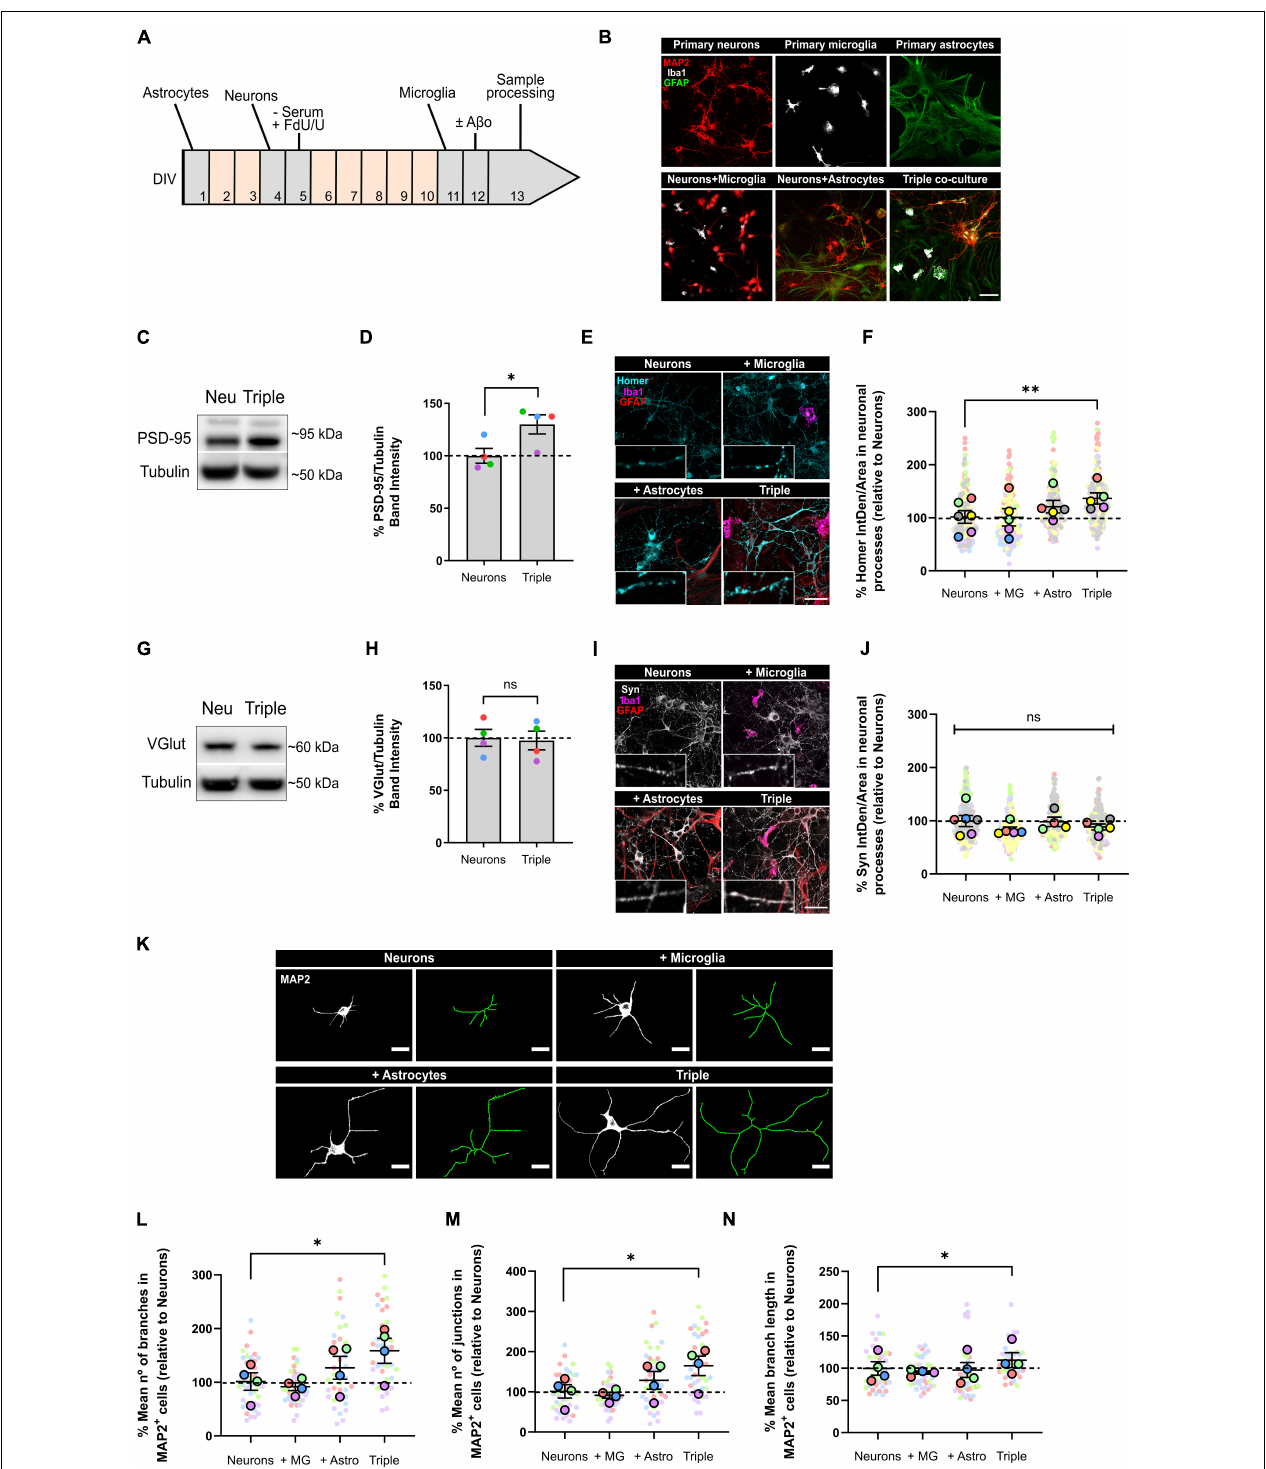
FIGURE 1 | Neurons increased the expression of post-synaptic markers PSD-95 and Homer1, and developed more and longer branches when co-cultured with microglia and astrocytes. (A) Protocol diagram for the in vitro triple co-culture model and (B) representative images. Cultures started with a monolayer of astrocytes. Neurons were plated 3 days later (ratio: five neurons to two astrocytes), and microglia were added 7 days after neurons (ratio: one microglia to five neurons). Cultures were maintained for 13 DIV in total. Scale bar = 50 µ m. (C) Representative western blot image of post-synaptic marker PSD-95 in total lysates. (D) Quantification